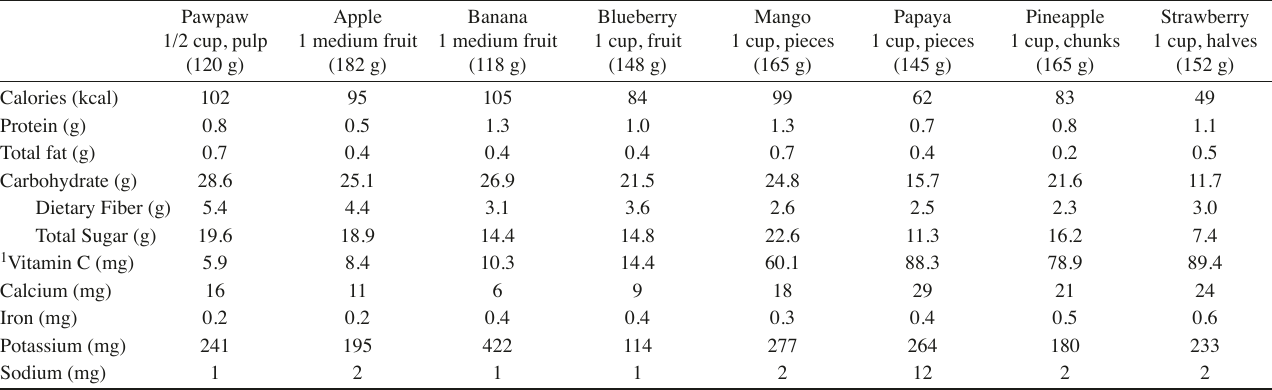
Tab. 7: Comparison of pawpaw nutritional information from this study (except where noted) to existing nutritional information (US D EPARTMENT OF A GRI- CULTURE , 2020) for seven common fruits per